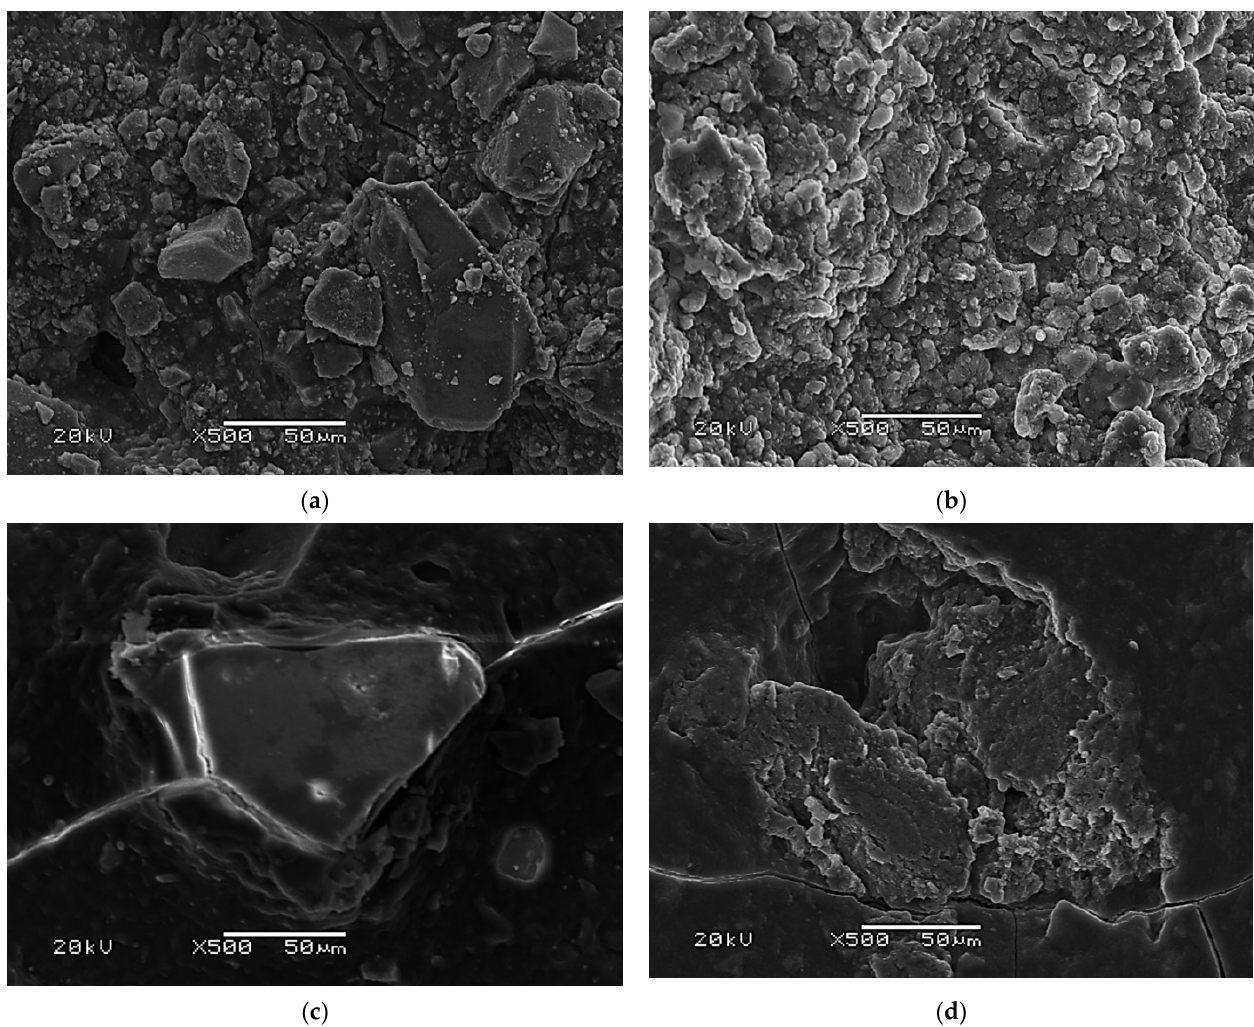
Figure 8. ( a ) SEM morphology of WPI A15 after incubation in Ringer’s fluid; ( b ) SEM morphology of WPI B15 after incubation in Ringer’s fluid; ( c ) SEM morphology of WPI A15 after incubation in distilled water; ( d ) SEM morphology of WPI B15 after incubation in distilled water.